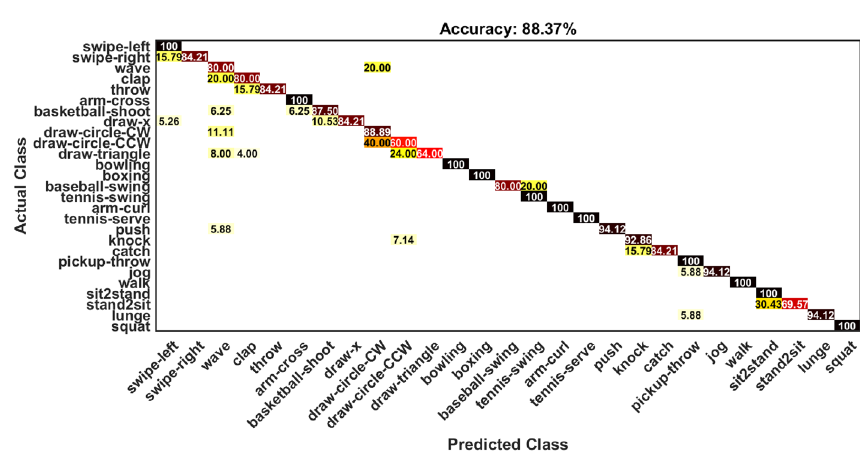
Fig. 11 Confusion matrix obtained for the UTD-MHAD dataset